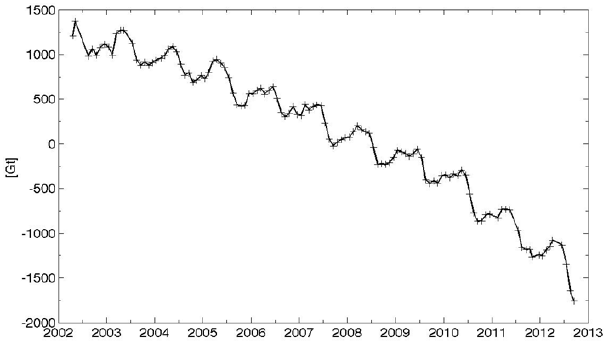
Fig. 8. Cumulative mass anomaly from GRACE updated through September 2012